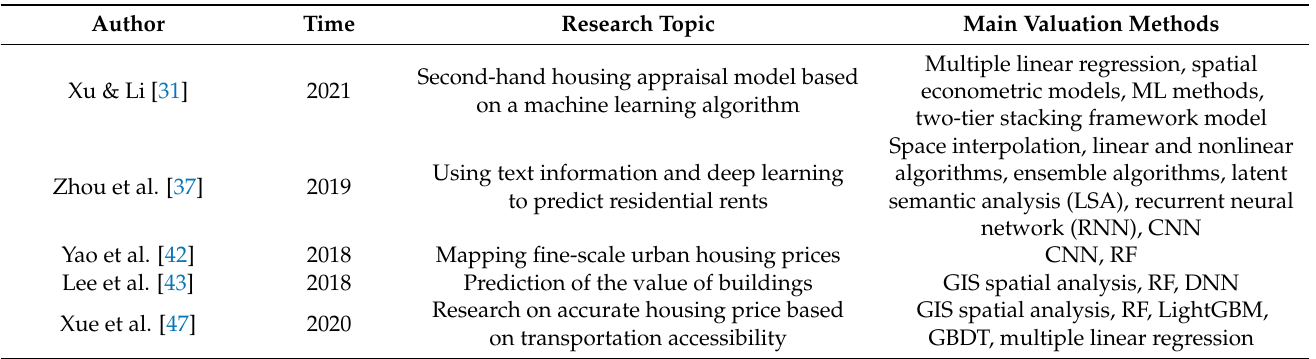
Table 2. Real estate appraisal methods in the era of big